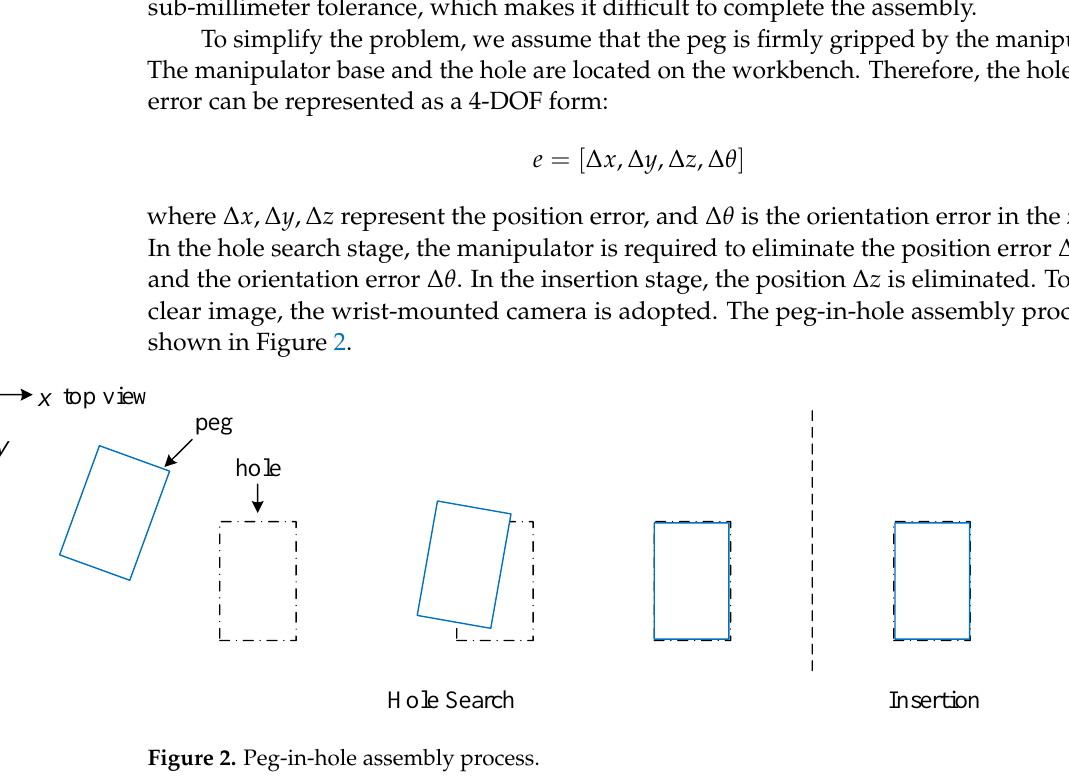
Figure 2. Peg-in-hole assembly process.